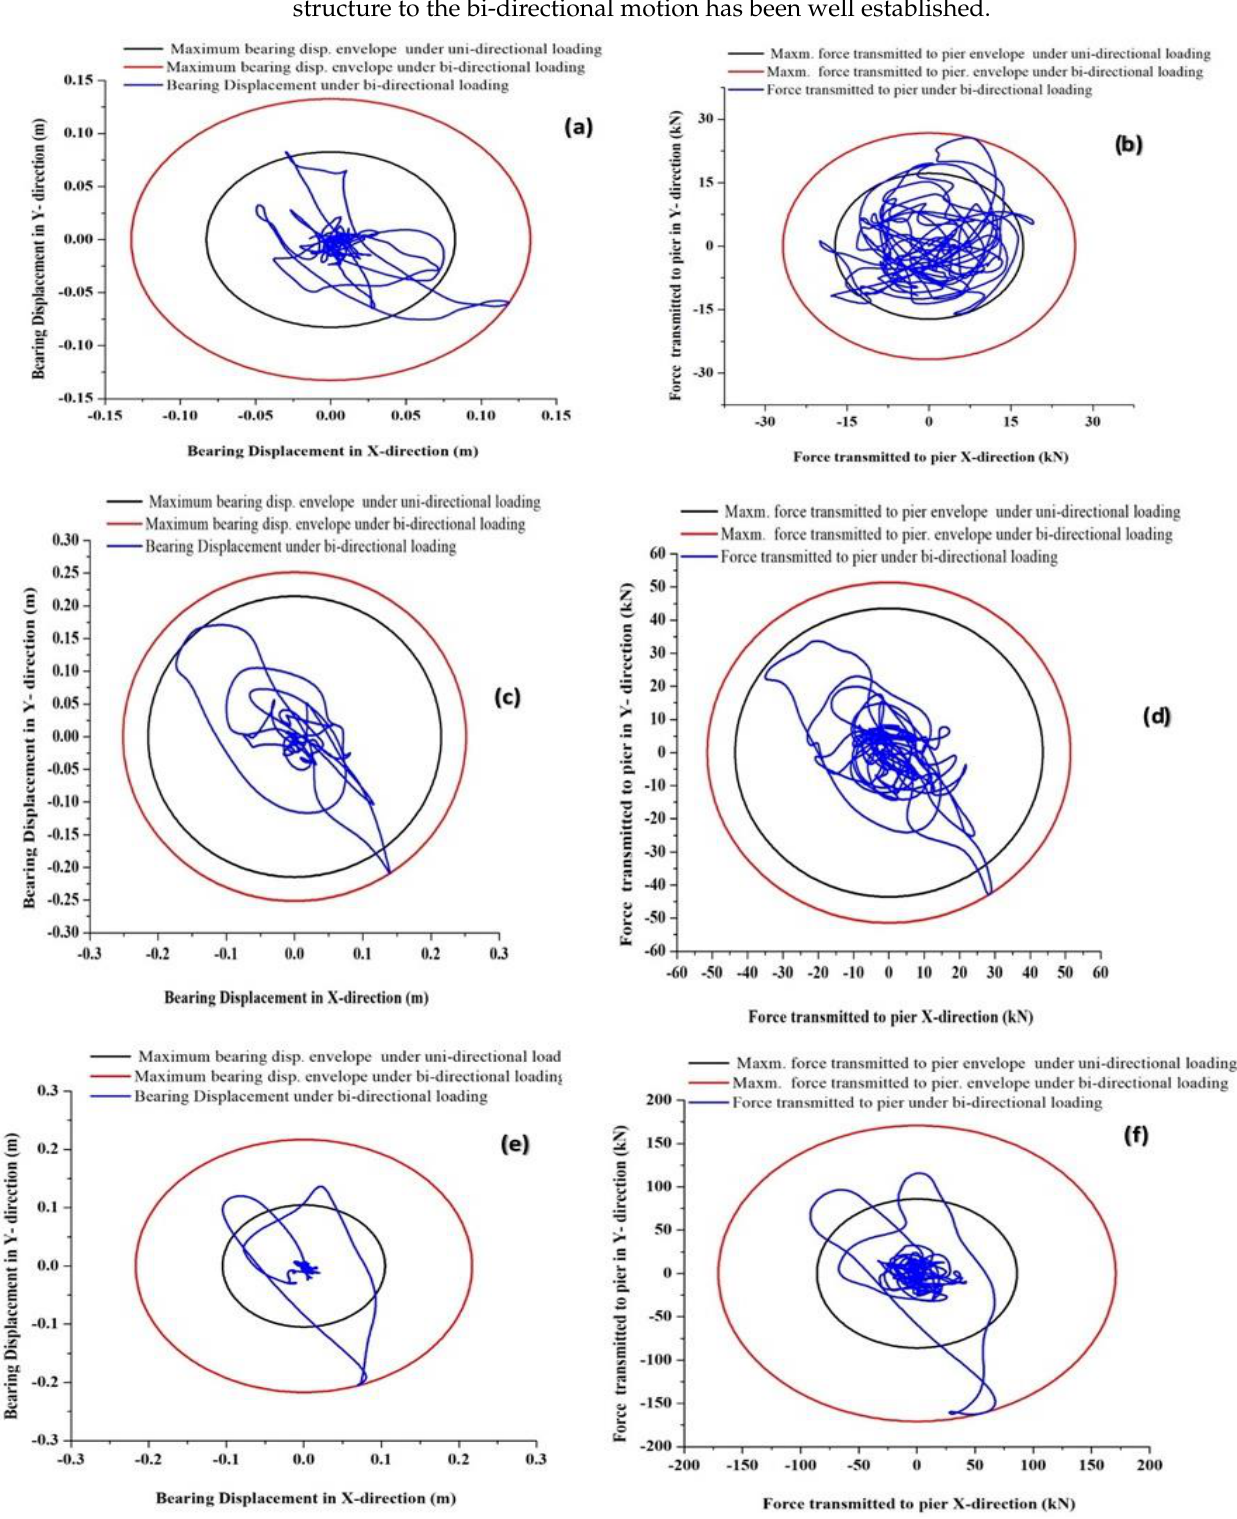
Figure 15. Response envelopes of the isolated bridge for Imperial Valley ( a , b ), Kobe ( c , d ), and Turkey ( e , f ) ground motions .